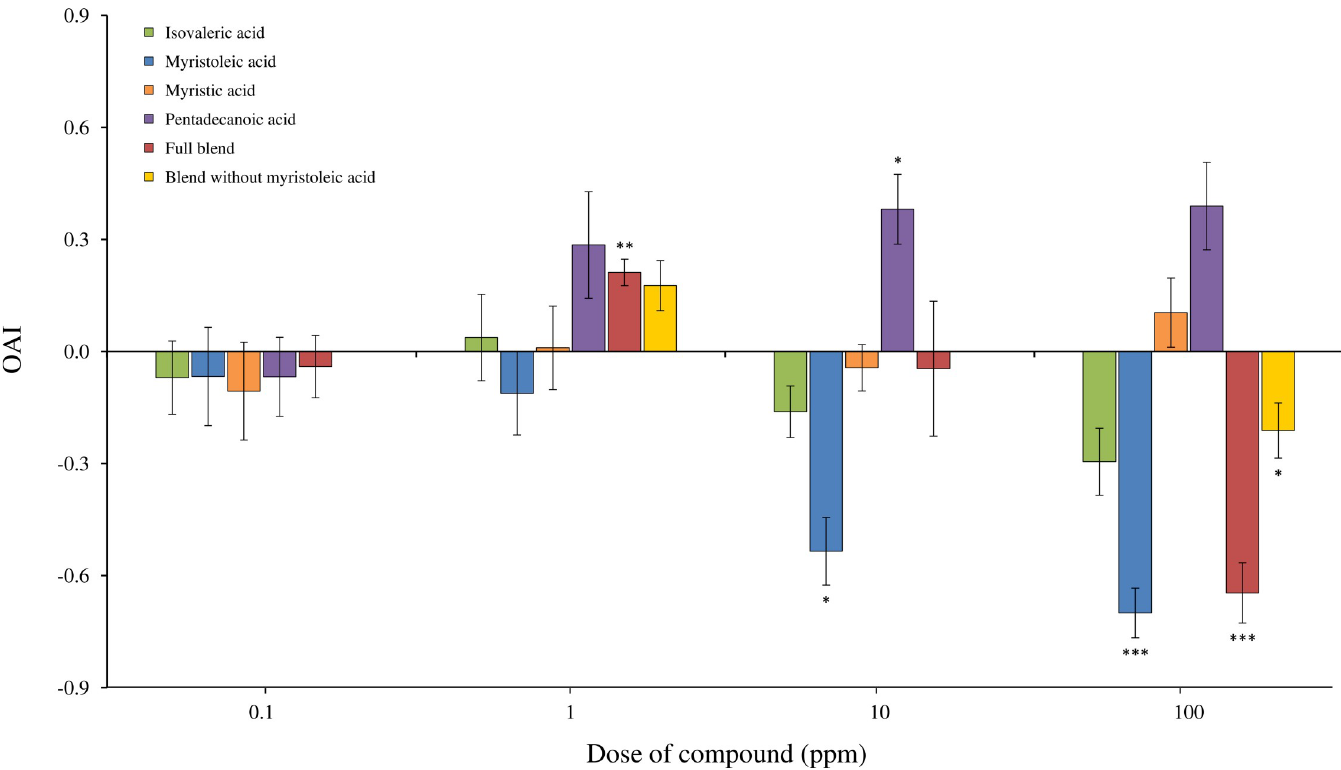
Fig 2. Oviposition activity index (OAI) of Ae . aegypti gravid females towards the different synthetic solutions at four different doses: 0.1; 1; 10 and 100 ppm (mean ± S.E.M., n = 5 replicates per condition). Asterisks show significant effect of the condition over water (paired Student’s t.test: � P < 0.05, �� P < 0.01, ��� P <